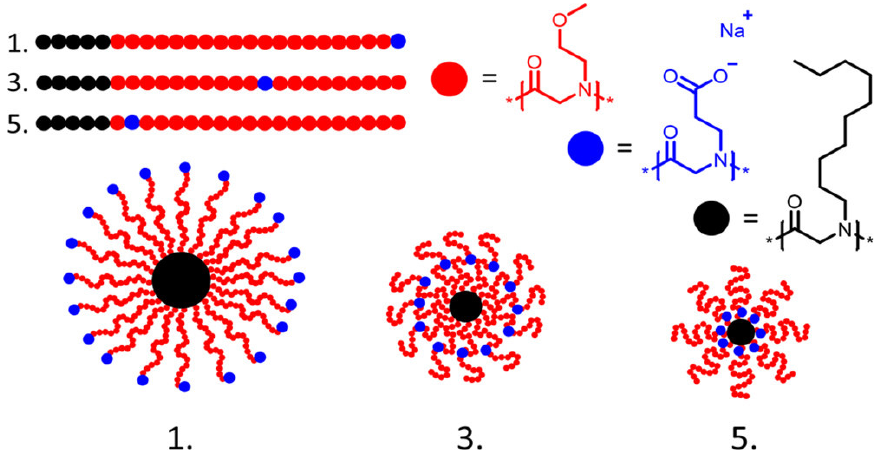
Figure 2. Chemical structures of representative sequences of ionic peptoid block copolymer (Adapted from ref. [31]. Copyright 2018, American Chemical Society).